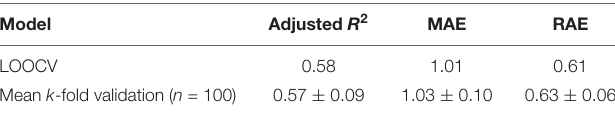
TABLE 3 | Average and standard deviation of error measures of generalized additive model predicting values of richness of invasive alien plants in riparian